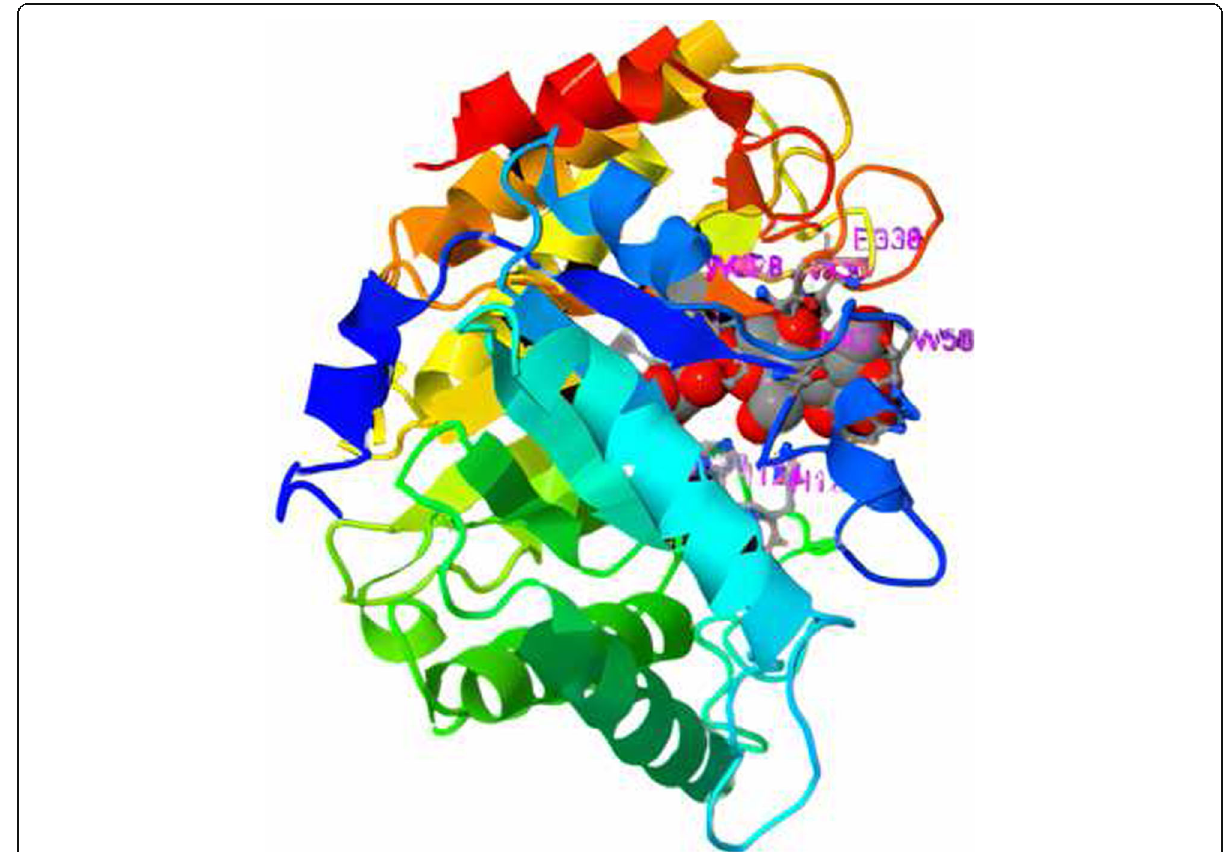
Fig. 7 Predicted ligand binding sites of cellulase from Ruminococcus albus